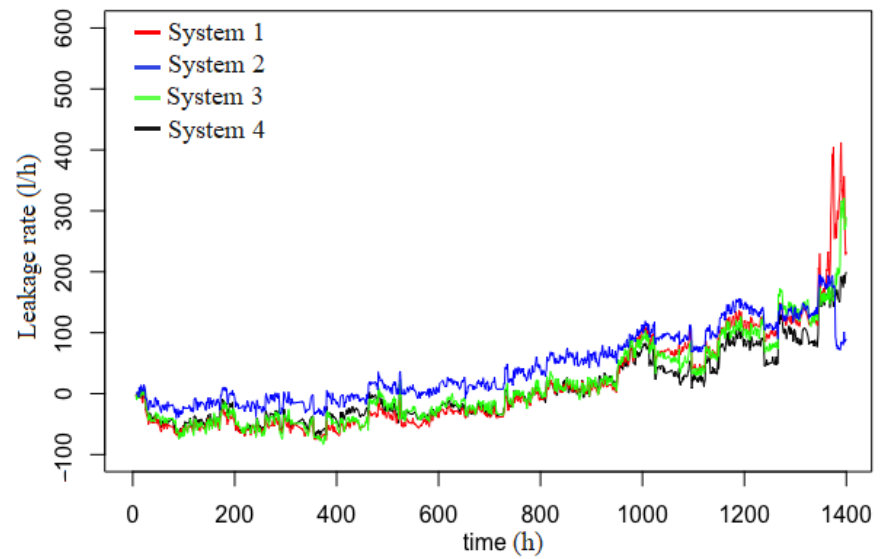
Figure 2. Leakage rate (L/h) of the four systems over a time